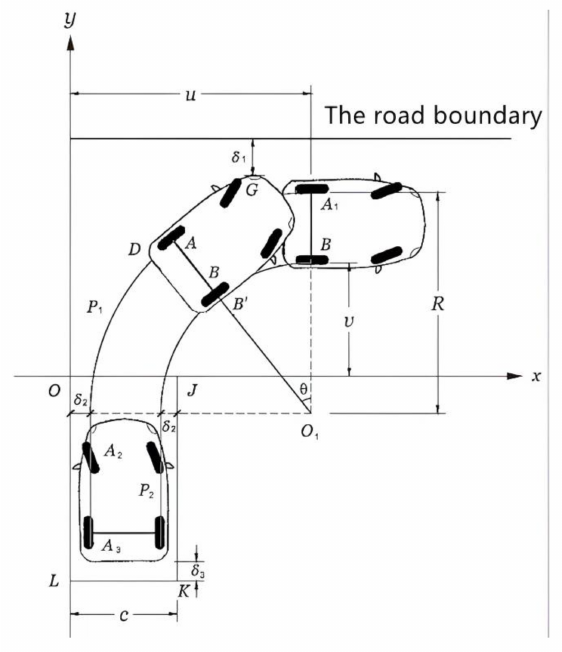
Figure 2. Schematic diagram of one-stage vertical parking